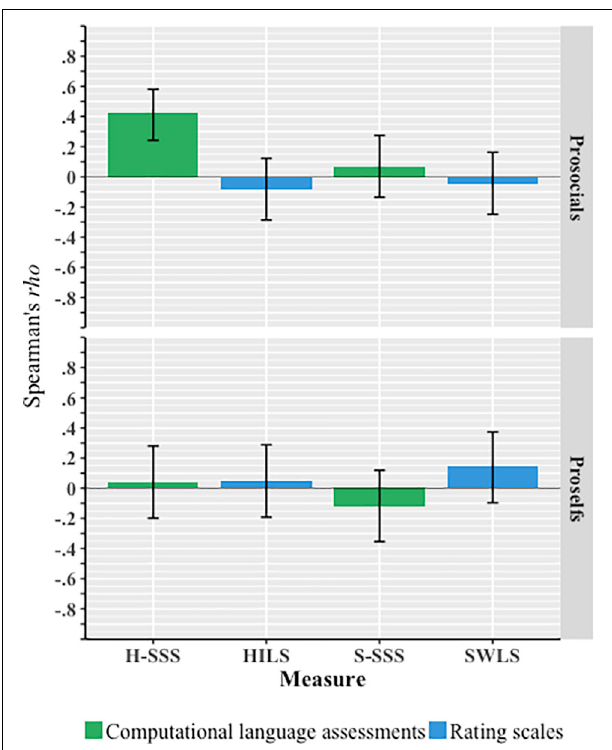
FIGURE 1 | Partial Spearman’s rho correlation (with 95% confidence interval) between each well-being measure and cooperation. The data were controlled for the three remaining well-being measures, language predicted valence, perceived financial situation, gender, and age for the various groups. Only H-SSS for prosocials was significant ( r = 0.41; p < 0.001); n = 69 prosocials, n = 59 proselfs. SSS, Semantic Similarity Scale; H, harmony; S, satisfaction; HILS, Harmony in Life Scale; SWLS, Satisfaction with Life Scale. Note that the n differs from Table 3 because partial correlation requires no missing values on all